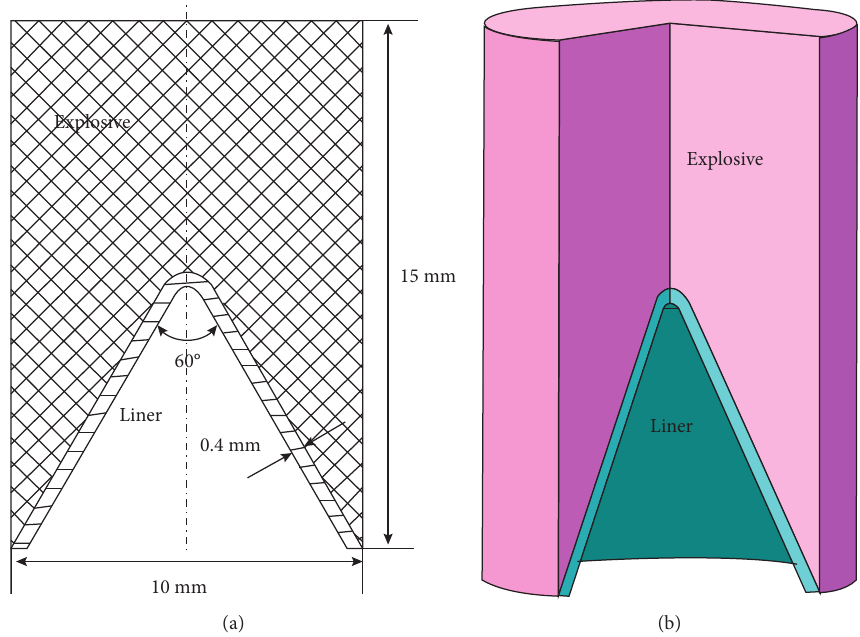
Figure 1: Geometric structure diagram of micro-shaped charge: (a) two-dimensional geometric structure and (b) 3D solid